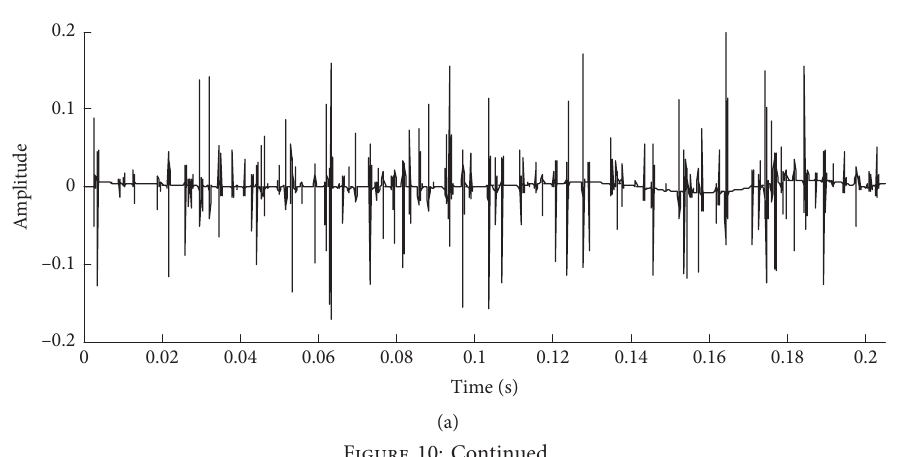
Figure 9: TQWT-SK decomposition result.